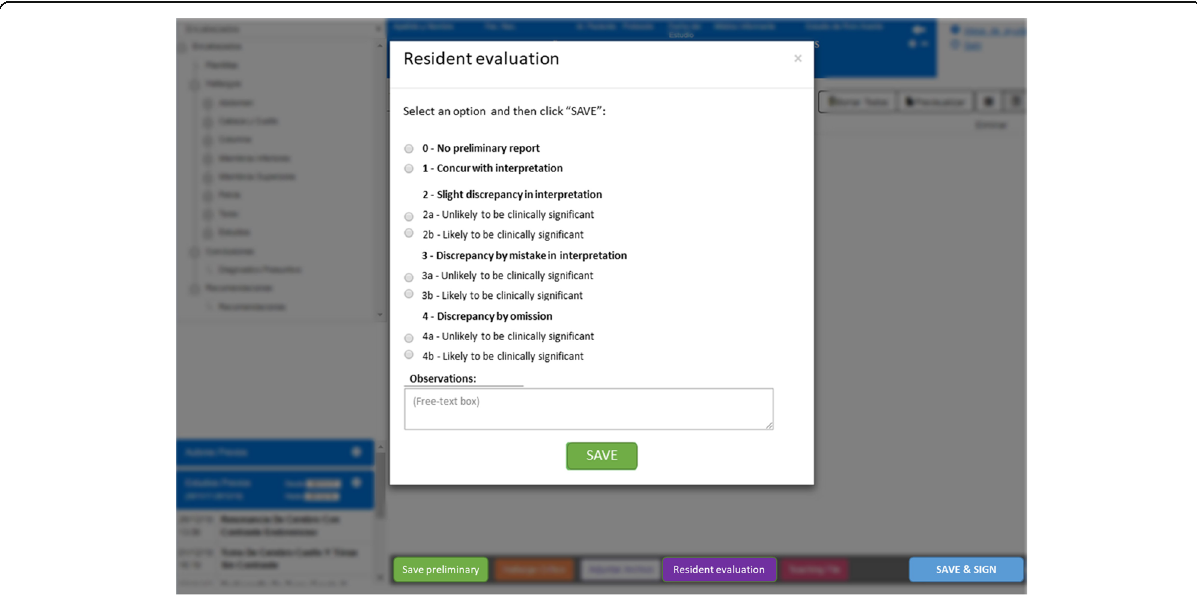
Fig. 1 Informatics tool interface. An example of the resident evaluation tool in our reporting software. Workflow: the resident saves the preliminary report (a). The attending radiologist interprets the study, opens the resident evaluation application form (b), and qualifies the preliminary report (c, in this case, concurring with interpretation) in order to finally save and sign the study